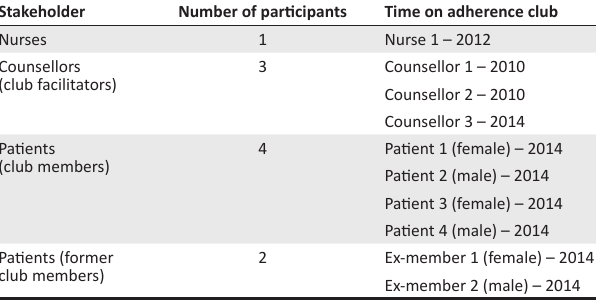
TABLE 1: Characteristics of study participants for the qualitative interviews.